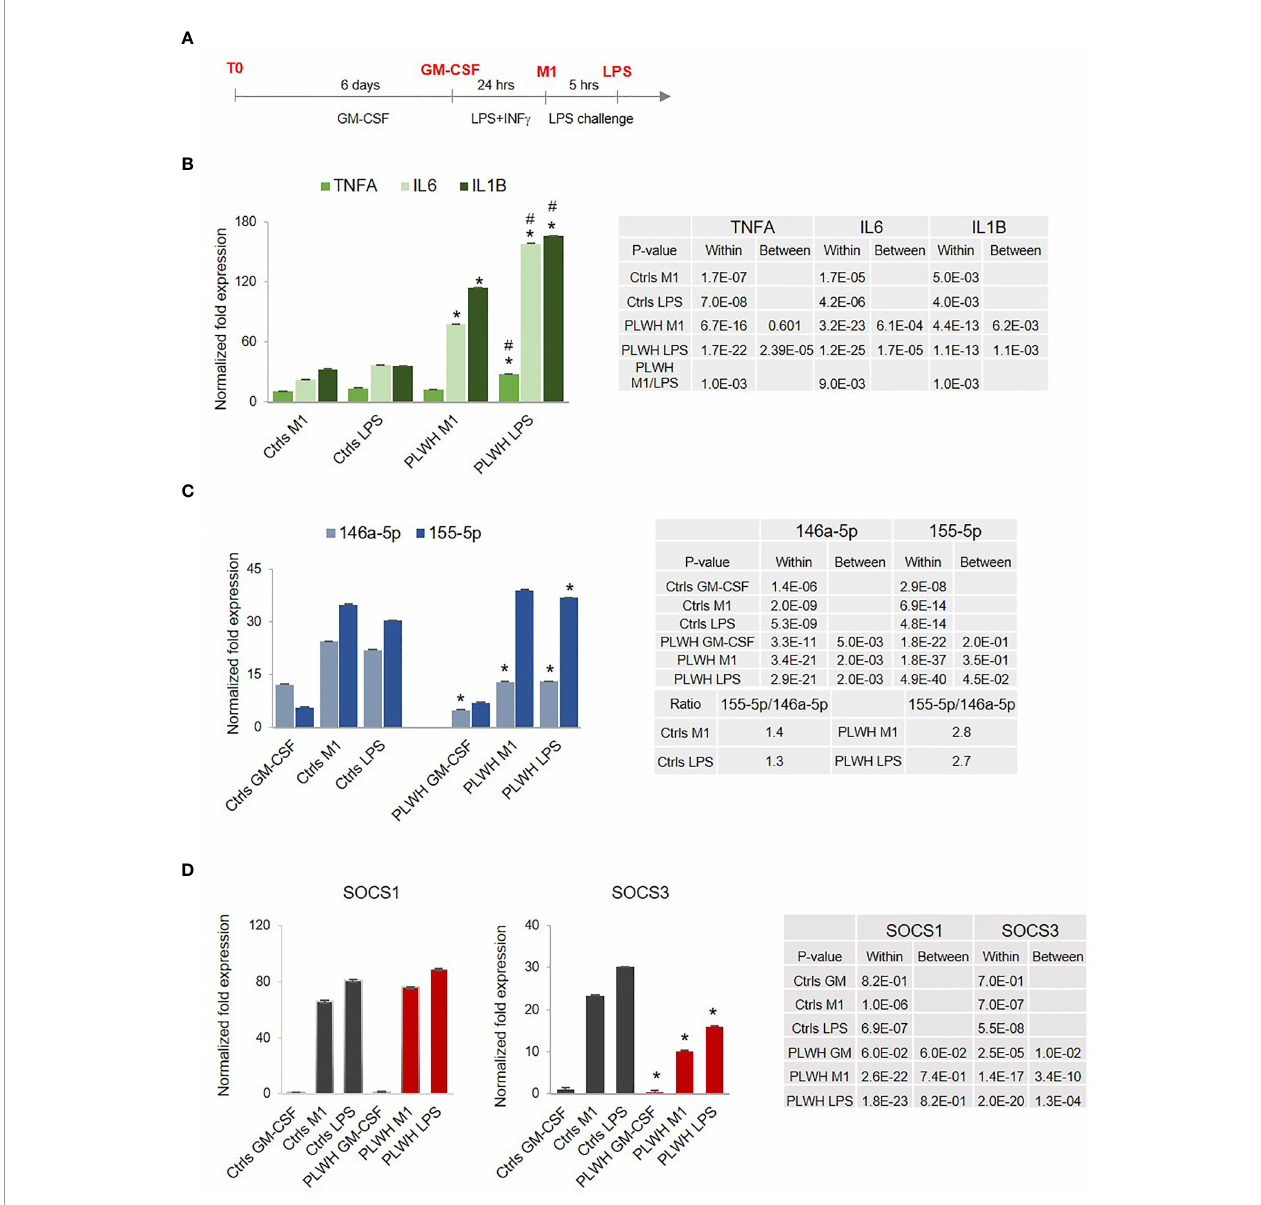
FIGURE 1 | Hyper-responsiveness of PLWH-MDMs. (A) Diagram showing the experimental approach to mimic endotoxin tolerance in control- (Ctrls) and PLWH- MDMs (PLWH). In red are the four different experimental stages of monocyte cultures: T0, GM-CSF, M1, and LPS. (B) Normalized fold expression of TNFA , IL6 , and IL1B mRNAs in MDMs over GM-CSF values. # Indicates statistical signi fi cance between M1 and LPS in PLWH group. (C) Relative expression of miR-146a-5p and miR-155-5p in control- and PLWH-MDMs in the indicated treatments represented by the normalized fold change over T0. The ratio between miR-155-5p and miR- 146a-5p in Ctrls and PLWH is shown in the Table (D) Relative expression of SOCS1 and SOCS3 mRNAs. In all graphs, error bars indicate SEM; *indicates statistical signi fi cance between groups (Ctrls, n=10, and PLWH, n=25) in the same cell treatments (M1 or LPS). The tables report speci fi c P -values calculated within each group and between